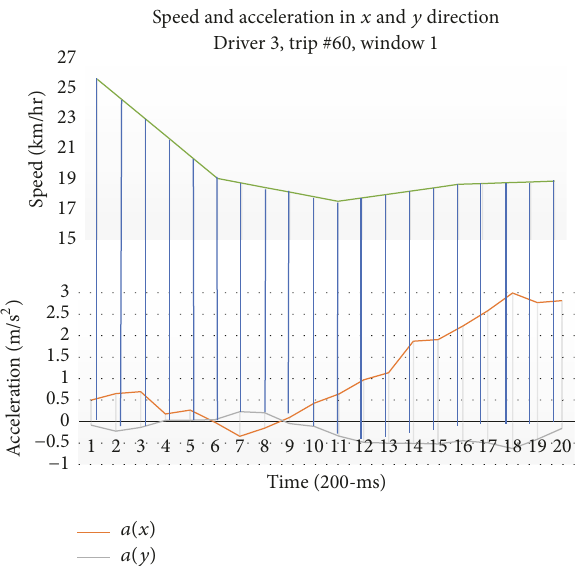
Figure 6: The two line graphs below represent the mean of accel- eration in 𝑥 and 𝑦 direction, computed as described in Section 3.3. The top line graph represents the interpolated speed. The vertical lines show how each speed information corresponds with the